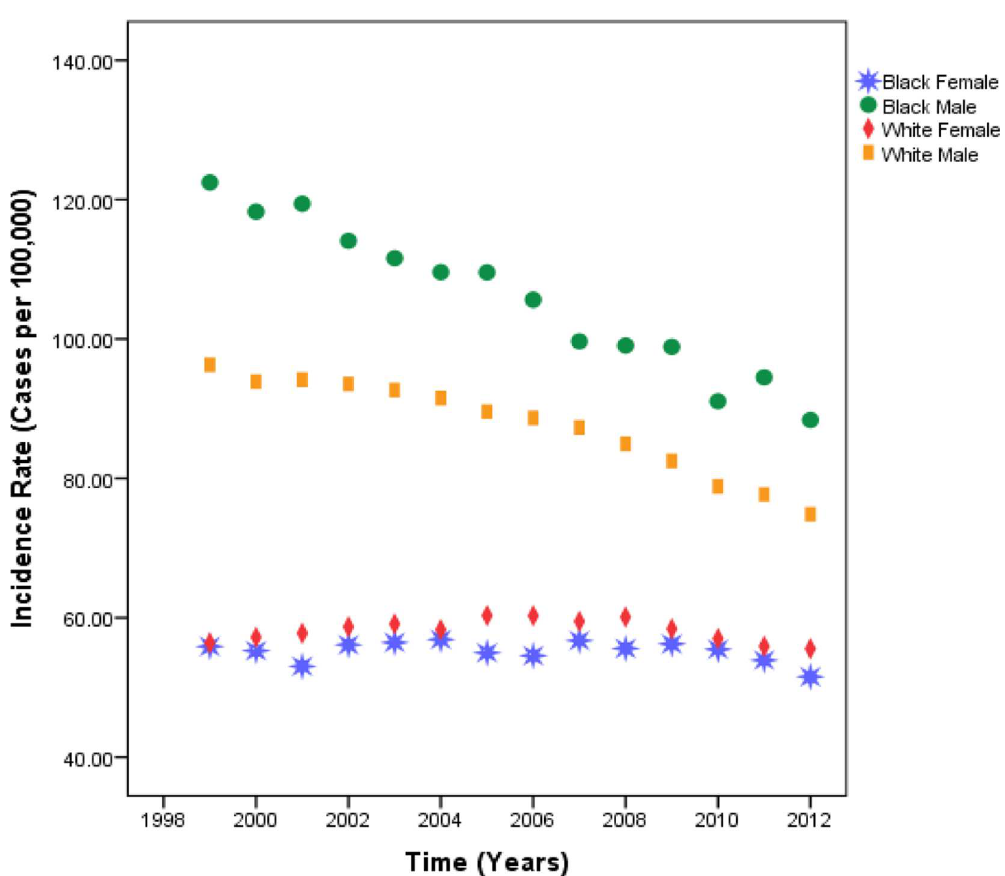
Fig 2. Estimates of lung cancer mean incidence rates by race and gender across all U.S. geographic regions,